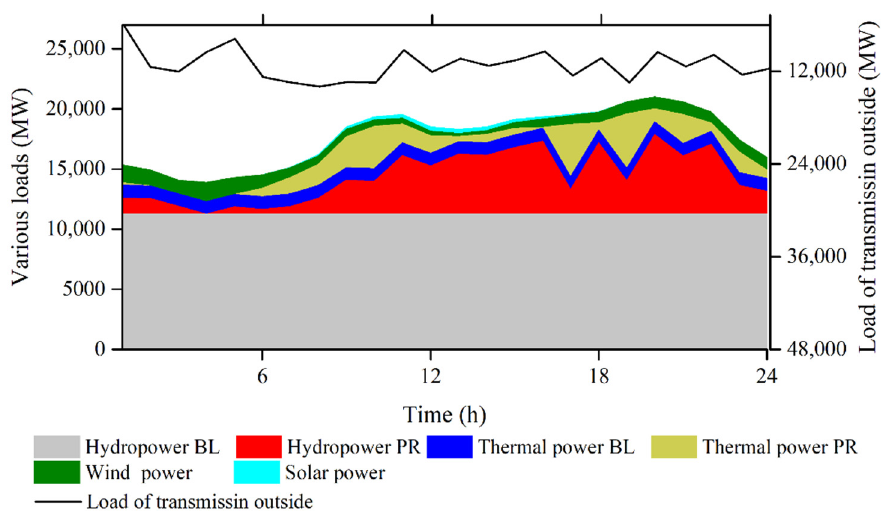
Figure 6. Diurnal dynamic of various loads under the power balance condition in the optimal equilibrium solution for YnPG as sending-end of the grid-connected hybrid energy system.